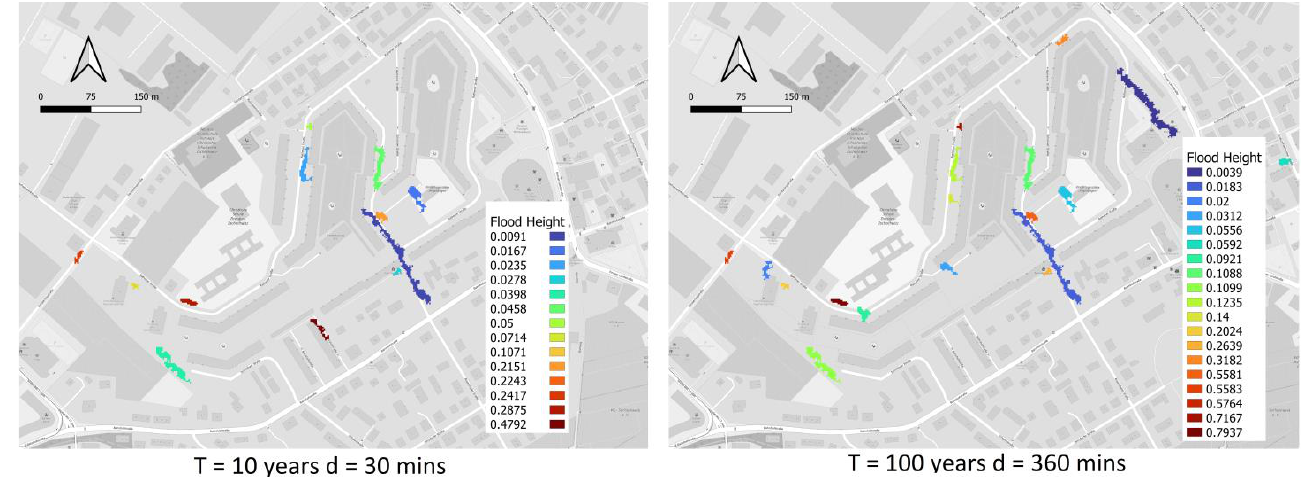
Figure 3. Reference scenario flood map for the two extreme events.